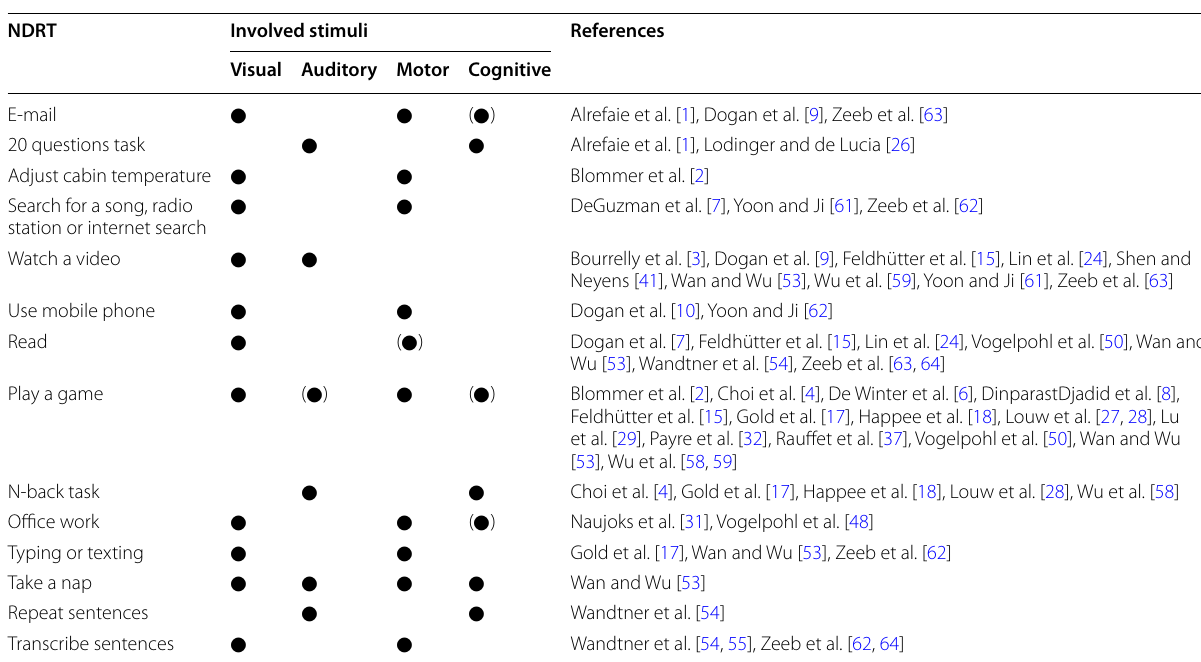
Legend: ● the NDRT involves this type of distraction; ( ● ) in some experiments, the NDRT may involve this type of distraction